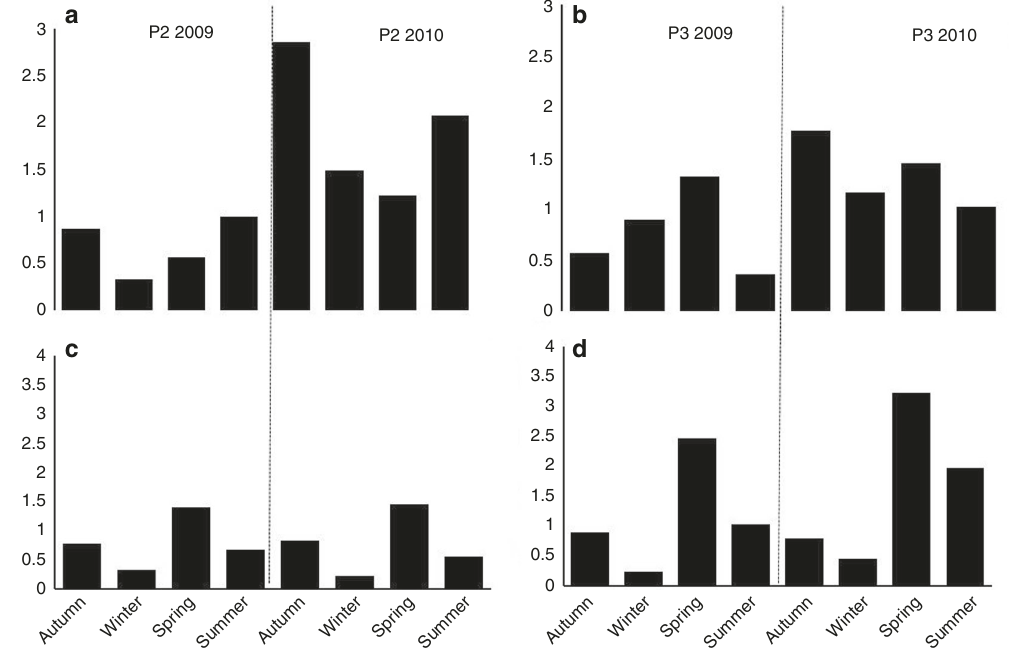
Fig. 4 Variability of the stoichiometric ratio. Seasonal variability of the stoichiometric ratio of PIC: POC at P2 ( a ) and P3 ( b ) and BSi:PIC at P2 ( c ) and P3 ( d ) for each year (2009 and 2010)